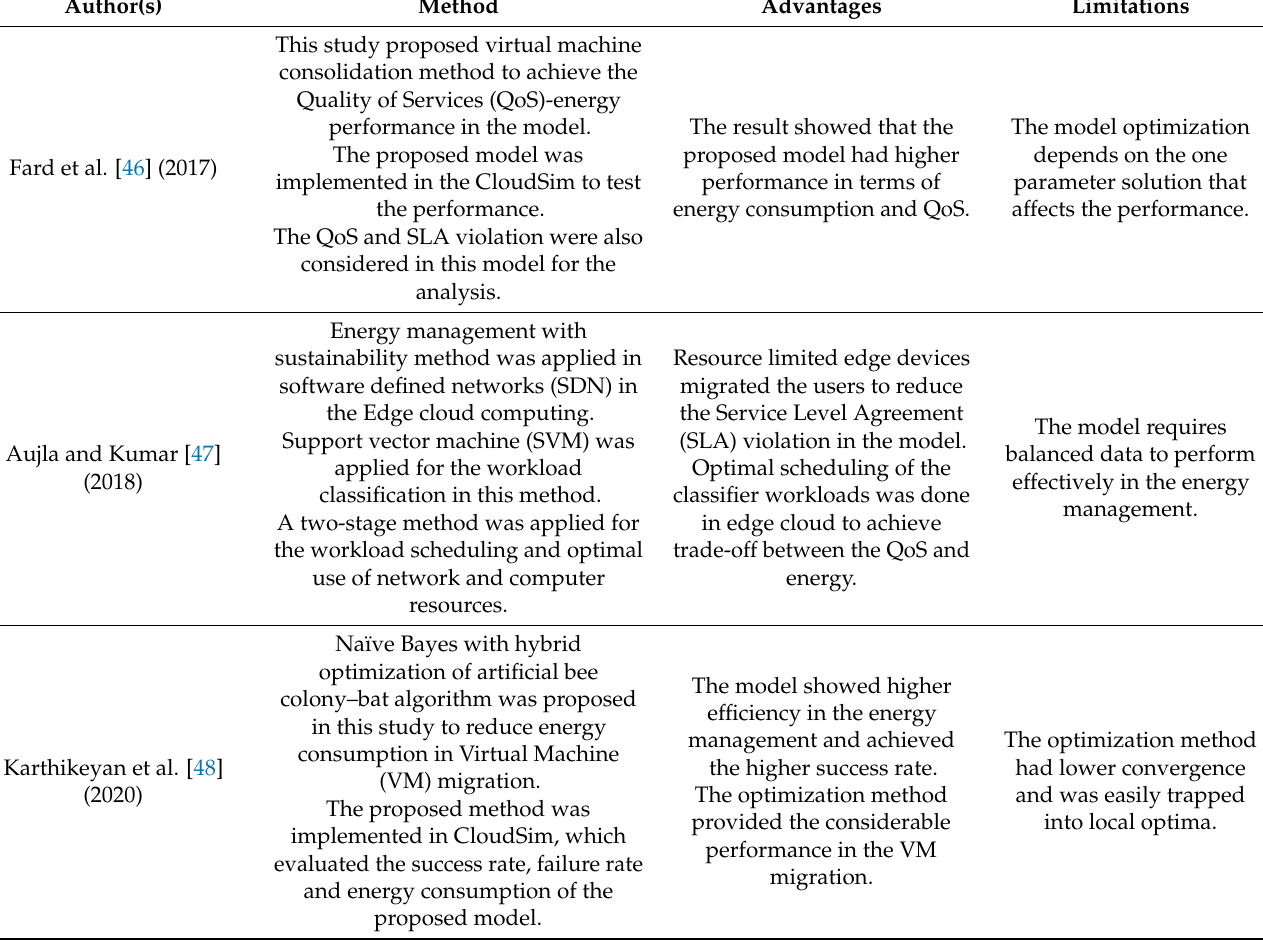
Table 2. Comparative analysis of existing energy efficiency in the